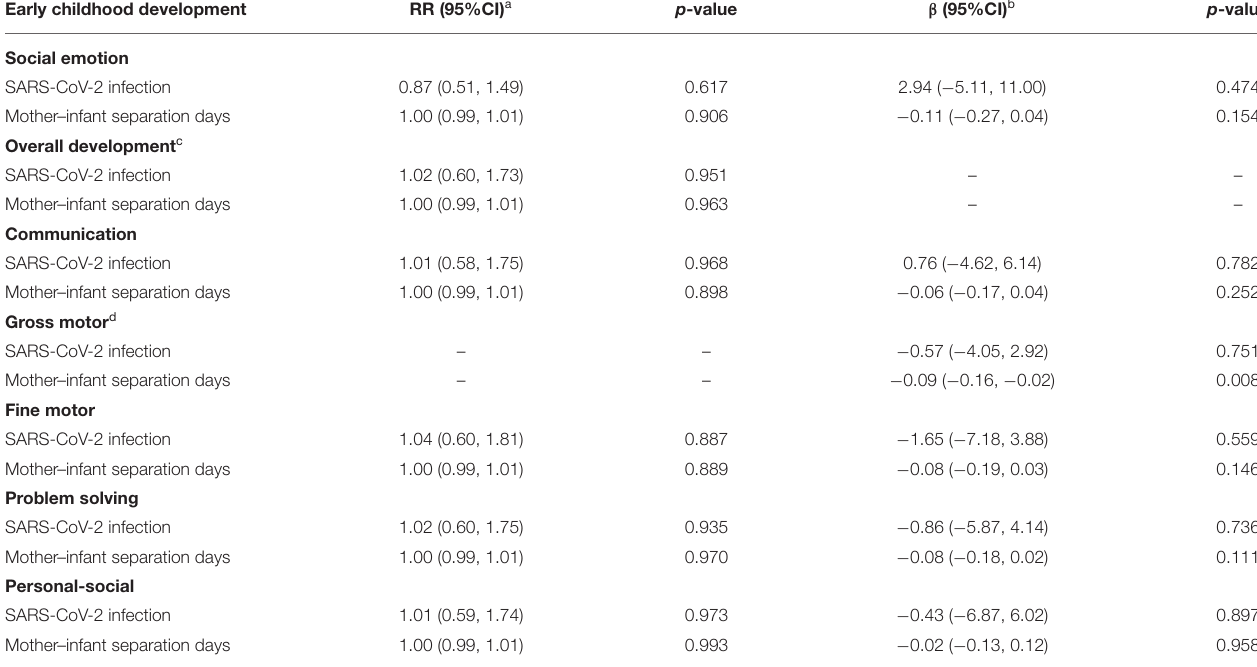
TABLE 2 | Association between SARS-CoV-2 infection and early childhood development. Early childhood